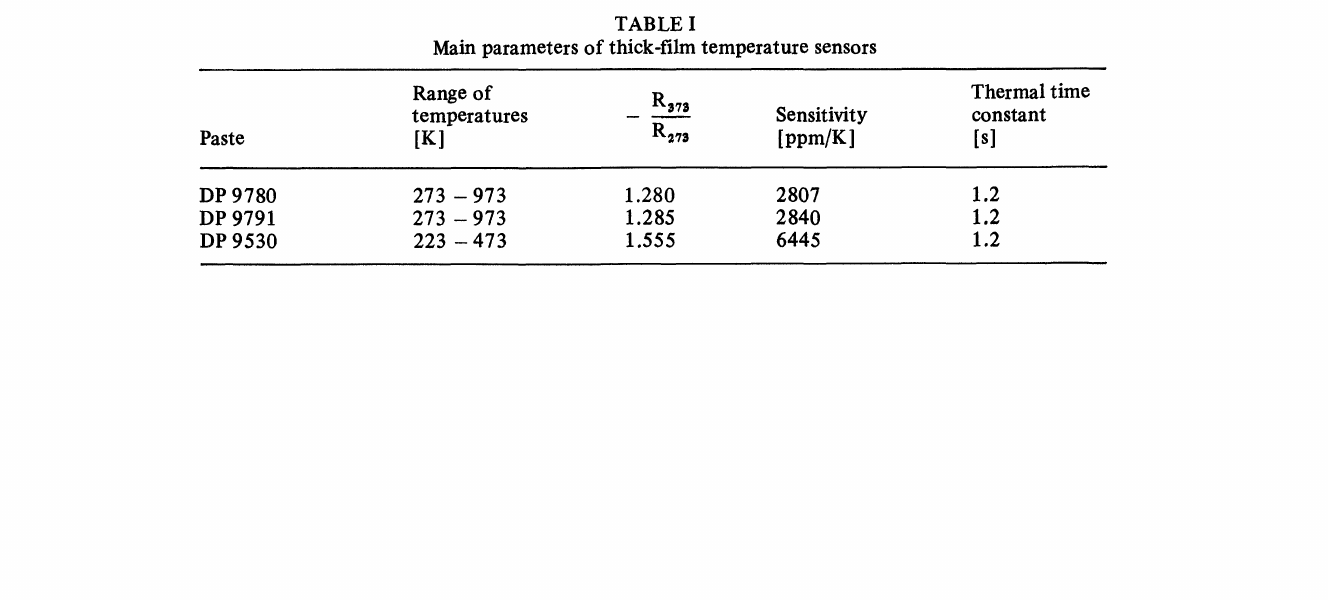
TABLE Main parameters of thick-film temperature